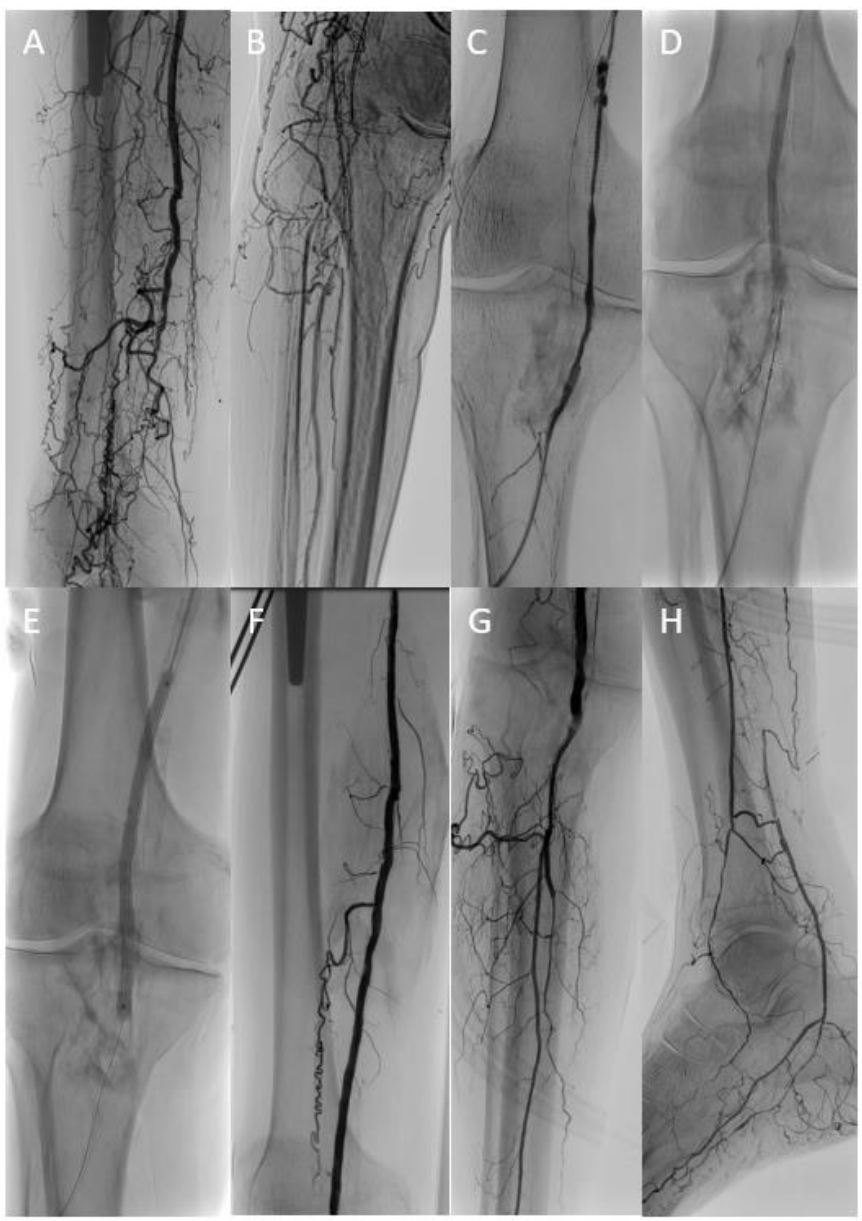
Figure 2. In a patient with critical limb ischemia and femoropopliteal occlusion ( A , B ), conventional recanalization attempts of the native artery and the chronically occluded femoropopliteal vein graft ( C ) were unsuccessful. Finally, target balloon-assisted re-entry with a retrogradely inserted GoBack™ catheter ( D ) enabled successful wire passage and adjunctive therapy of the native femoropopliteal segment ( E – G ) with a single-vessel run-off ( H ).